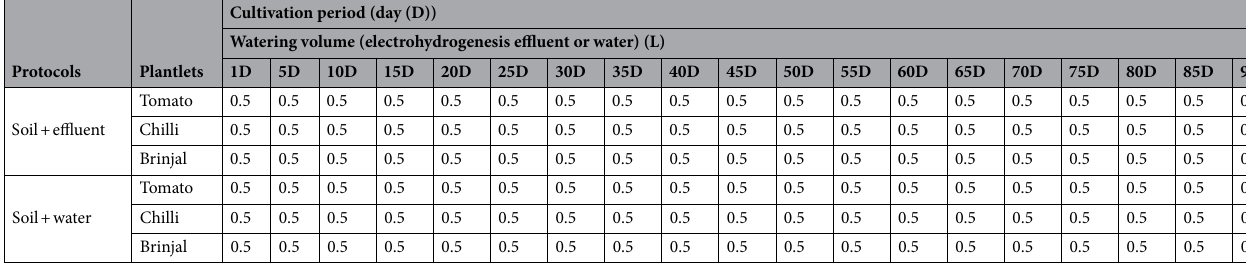
Table 1. Experimental setup for plant